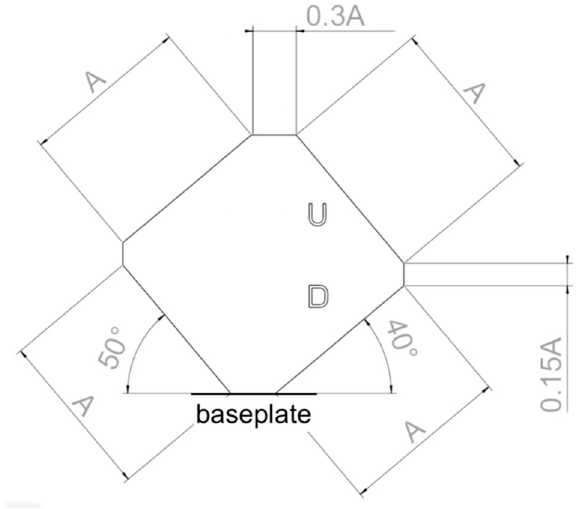
Figure 5. Recommended specimen geometry to be used for assessing boundary parameters.